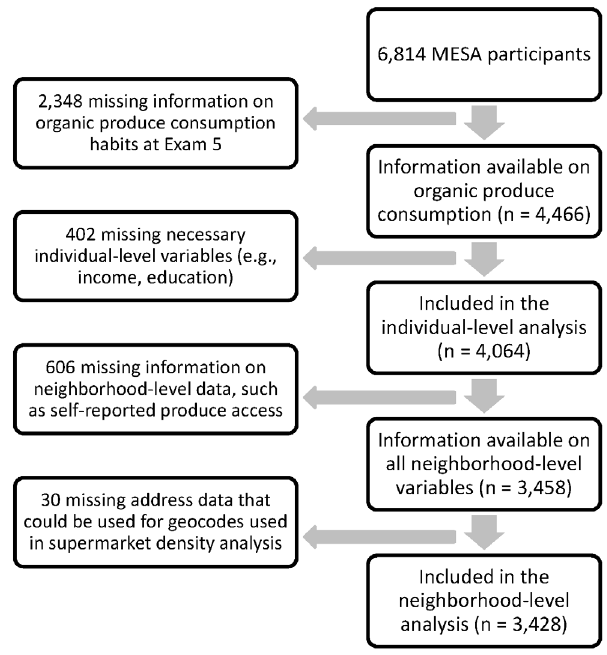
Figure 1. Exclusion criteria and sample sizes for the individual- and neighborhood-level analyses. The largest data loss occurs between study enrollment in 2000–2002 and Exam 5, in which this study occurs, in